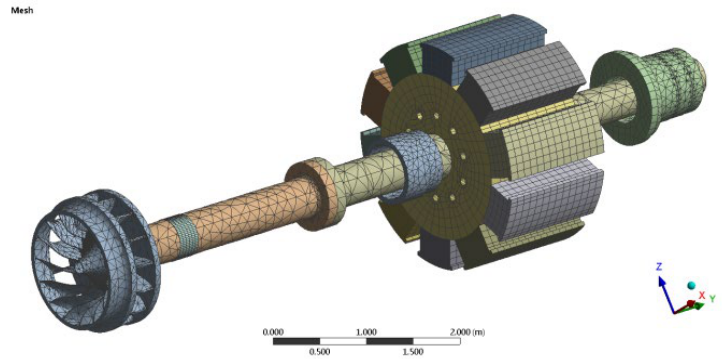
Figure 2. Solid geometry model of Shafting system.